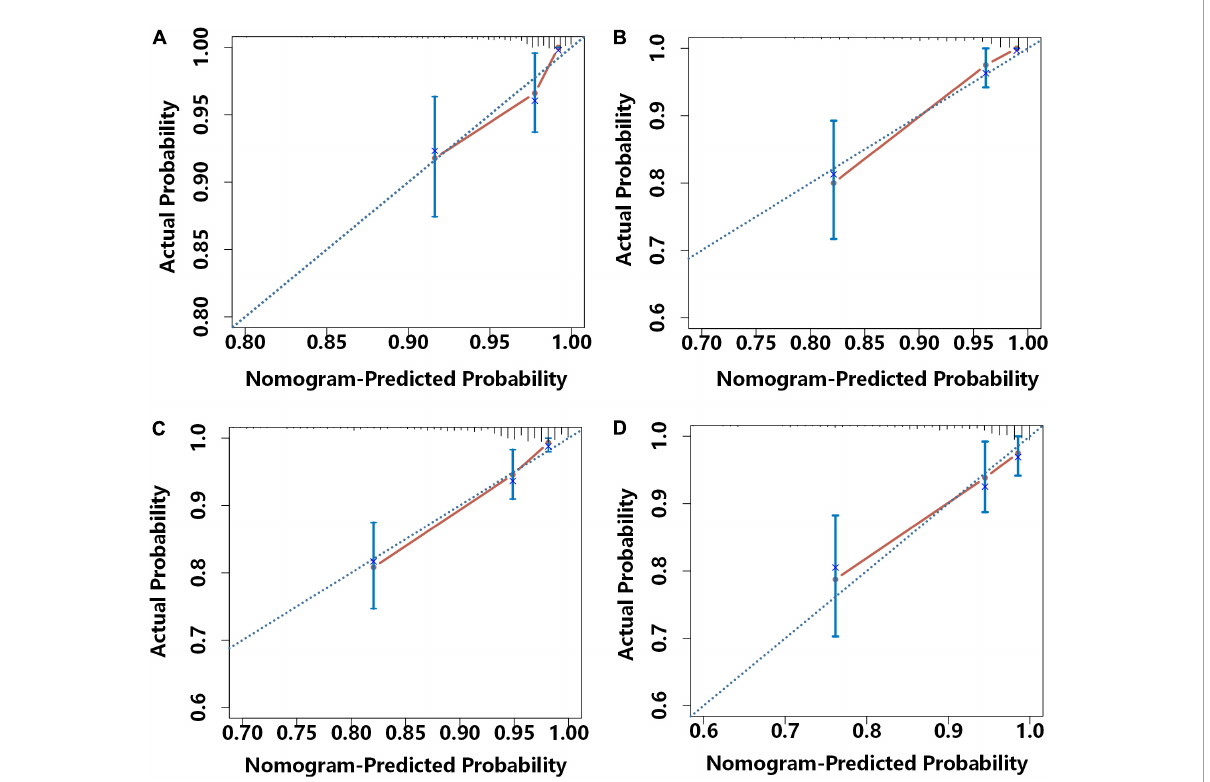
FIGURE5 Calibration curves for the prediction of the risk for 1-year MACE-free survival in the development cohort (A) and the external validation cohort (B) and 2-year MACE-free survival in the development cohort (C) and the external validation cohort (D) . Each plot shows the relationship of the nomogram-predicted probability (abscissa) and the actual probability (ordinate) Each light blue diagonal line represents the ideal reference line (in which predicted survival probabilities match observed survival rates) and each red line was calculated by bootstrap resampling (500 times), and represents the performance of the nomogram. Thus, a greater similarity of the red and blue lines indicates more accurate predictions of survival.